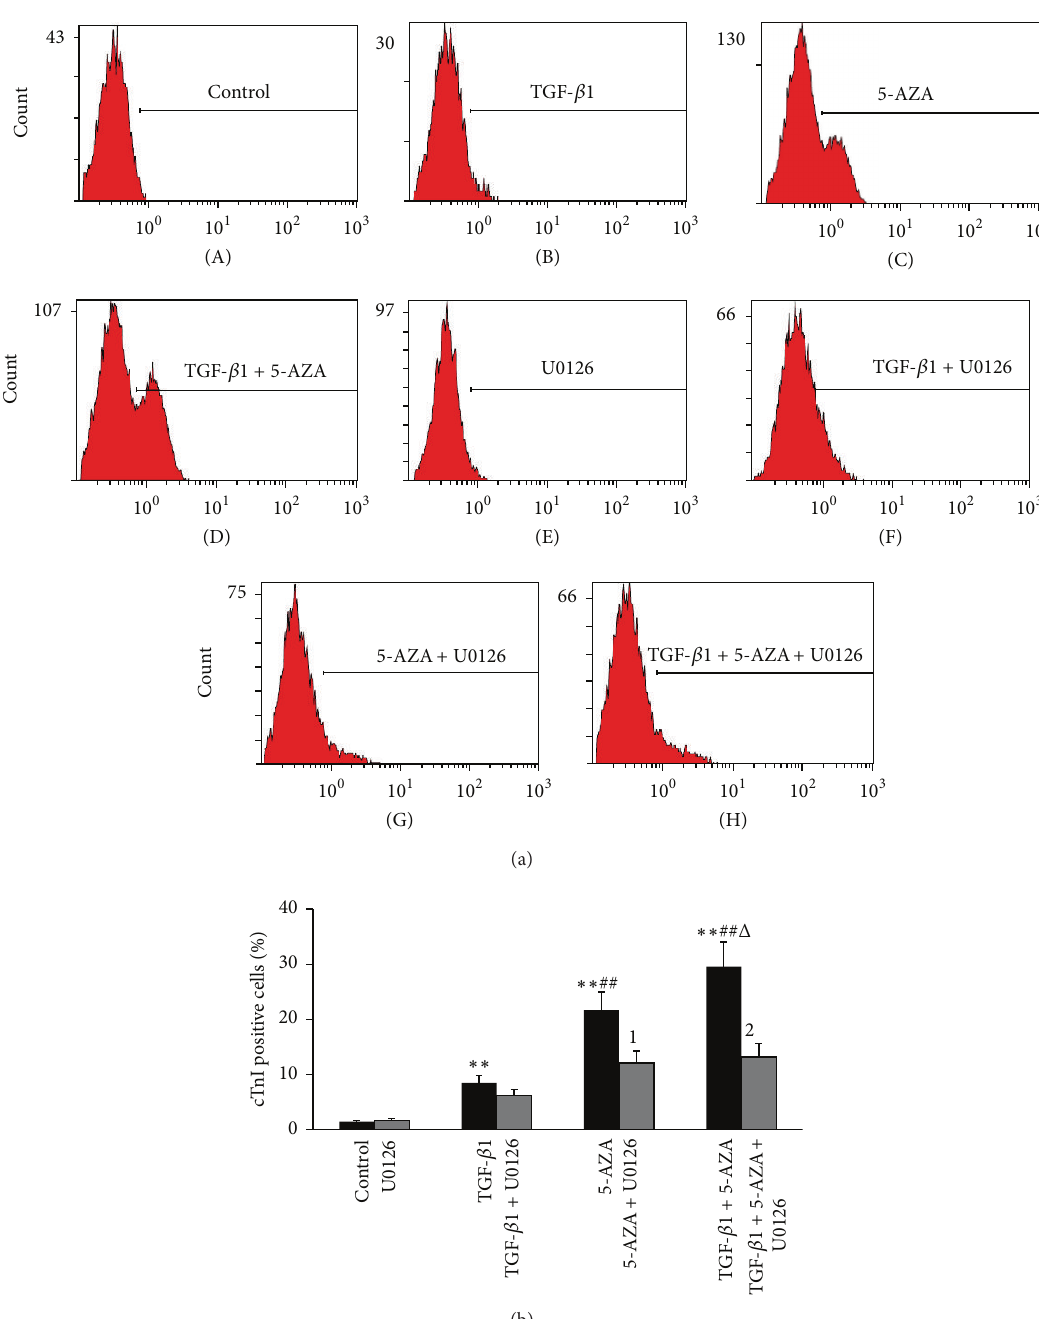
group, TGF- 𝛽 1 + 5-AZA, was the highest among the 4